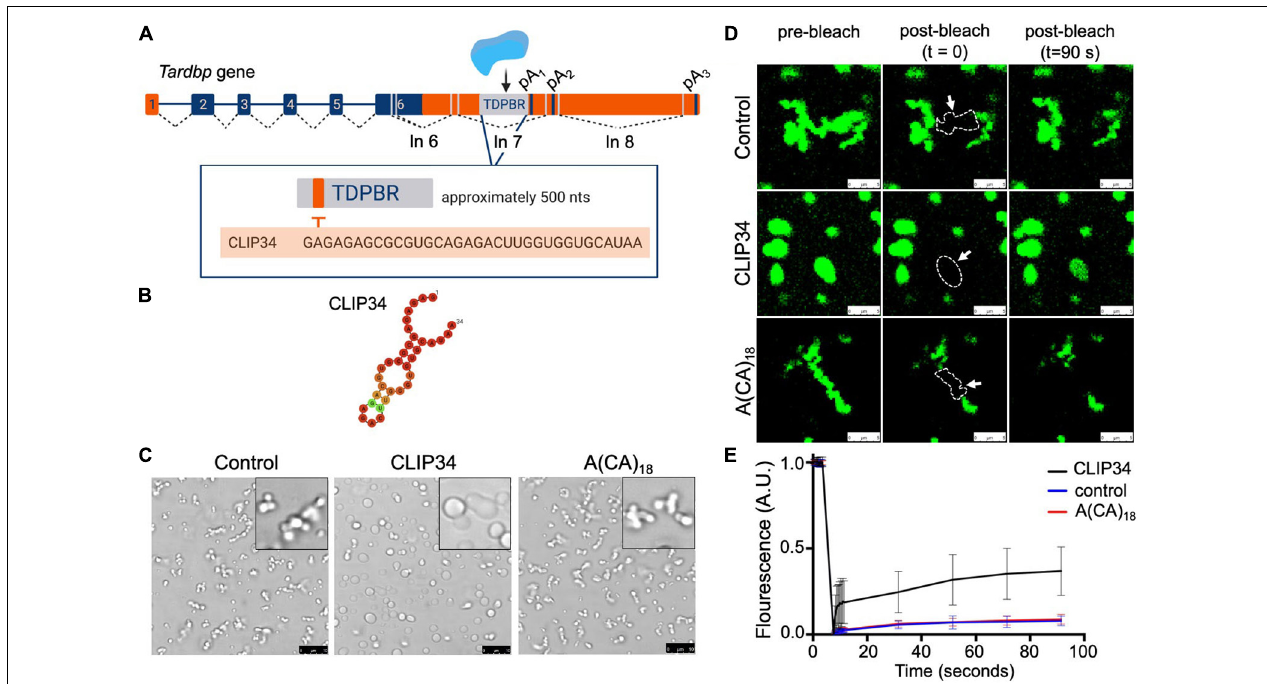
FIGURE 1 | Binding to the RNA region mediating TDP-43 autoregulation increases the liquid properties of TDP-43 condensates. (A) Tardbp pre-mRNA organization into introns (lines) and exons (boxes), highlighting coding regions (blue boxes). Splicing is denoted by dashed lines and the approximate positions of alternative splicing in the 3 (cid:48) UTR are shown (gray lines). TDP-43 binds to its cognate mRNA transcript in the 3 (cid:48) UTR TDP-43 binding region (TDPBR, gray box), including the 34-nt sequence CLIP34. (B) Lowest free energy secondary structure of CLIP34 predicted by RNAfold. The calculated frequency of this structure in the ensemble is 53%. (C) Condensates formed by purified TDP-43 (4 µ M) as seen by brightfield microscopy without RNA (control), in the presence of CLIP34 RNA (4 µ M), or the non-specific control RNA A(CA) 18 (4 µ M) at 150 mM NaCl, pH 7.5. Representative images of 3 independent experiments from 2 protein preparations. Scale bars, 10 µ m. (D) Fluorescence recovery after photobleaching (FRAP) of condensates (white arrow) formed by Oregon green labeled-TDP-43 (10% of total protein) mixed with CLIP34, A(CA) 18 , or in the absence of RNA in the same experimental conditions as (C) . Dotted line and arrow define the region of interest. Scale bars, 5 µ m. (E) Quantification of fluorescence recovery in panel (D) , showing mean values and SD from 3 biological replicates consisting of 16 measurements, performed from 2 different protein